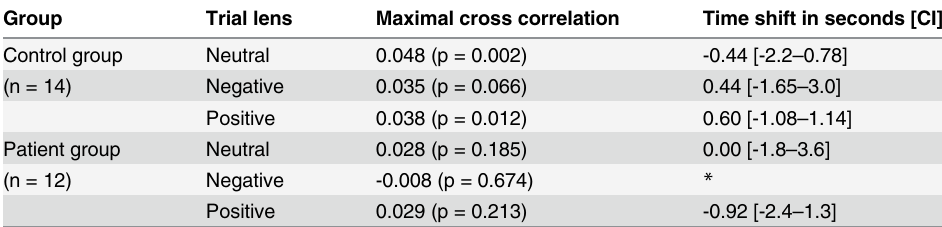
Cross-correlation analyses were run within groups (controls and patients) and viewing conditions. One sample t-test tested if maximal cross-correlation (R(time shift)) differed from zero (p-value in